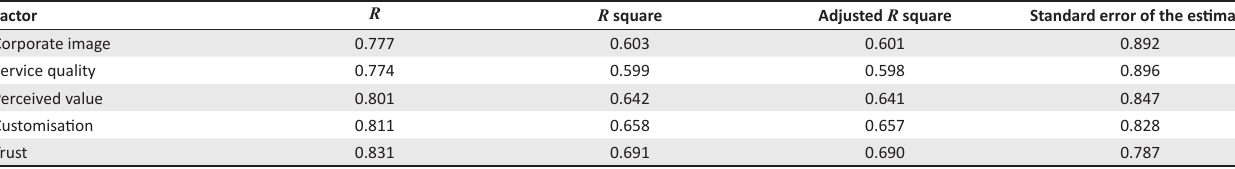
TABLE 3a: Influence of the independent variables on the dependent variable. Model 1 summary. Factor R R square Adjusted R square Corporate image